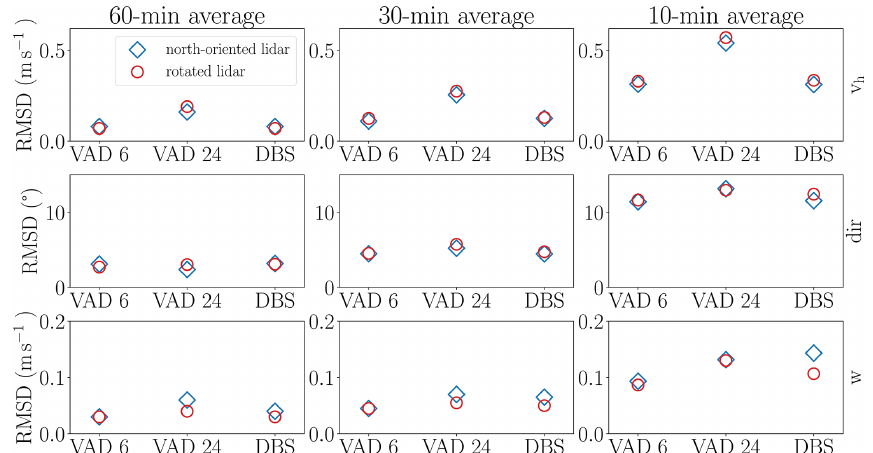
Figure 6. Simulation case 1: RMSD of virtual lidar measurements of wind speed, wind direction and vertical wind with reference to the “true” wind profile of the column located directly above the lidar. RMSD values were calculated over a height interval extending from 50 to 960m for measurements averaged over different time intervals. Shown are results for measurements with a zenith angle configuration of 15 ◦ . Measurements were obtained with different scan schemes (VAD 6, VAD 24 and DBS). Blue diamonds indicate results for north-oriented instruments, while red circles mark results for rotated instruments. Lidars were rotated 30 ◦ to the east for VAD scans and 45 ◦ to the east for DBS scans.